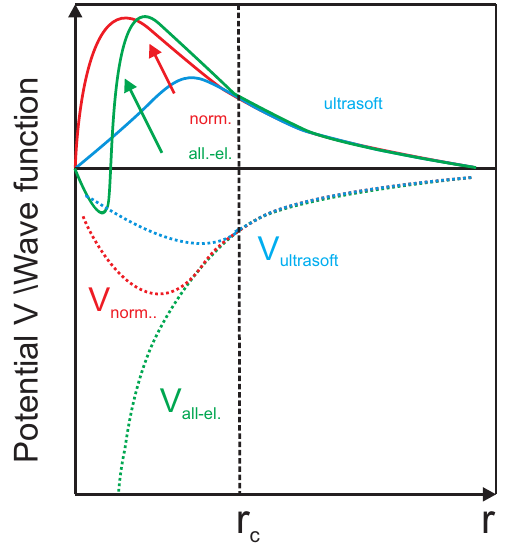
Figure B2. Exemplary comparison of the real wave function Ψ all.el. with the constructed norm-conserving and ultrasoft wave function Ψ norm. and Ψ ultrasoft . The artificial wave function does not exhibit nodes and allows them to be simulated with a smaller number of plane waves, especially for the ultrasoft wave function. Above r c , all wave functions show the same spatial evolution. Below r c , the electron density n ( (cid:126) r ) of Ψ ultrasoft differs from the true electron density, which must be renormalized. In contrast, Ψ norm. is considered to be norm conserving since its n ( (cid:126) r ) is equal to electron density of Ψ all.el. . To create the artificial wave function, the core potential has to be approximated by a corresponding V norm. or V ultrasoft potential being soften in the core region. This is actually the reason why the total wave function can be modeled by fewer plane